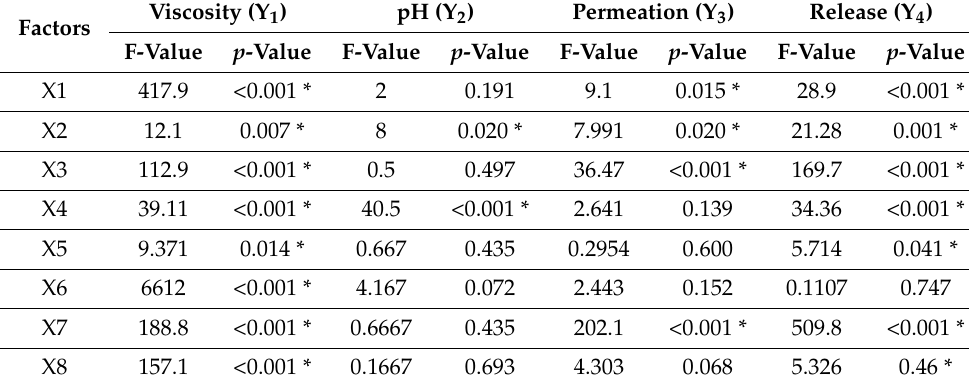
Table 2. Summarized results of analysis of variance (ANOVA) of experimental results for appar- ent gel viscosity (Y 1 ), pH (Y 2 ), % Curcumin permeation at 6 h (Y 3 ), % Curcumin release at